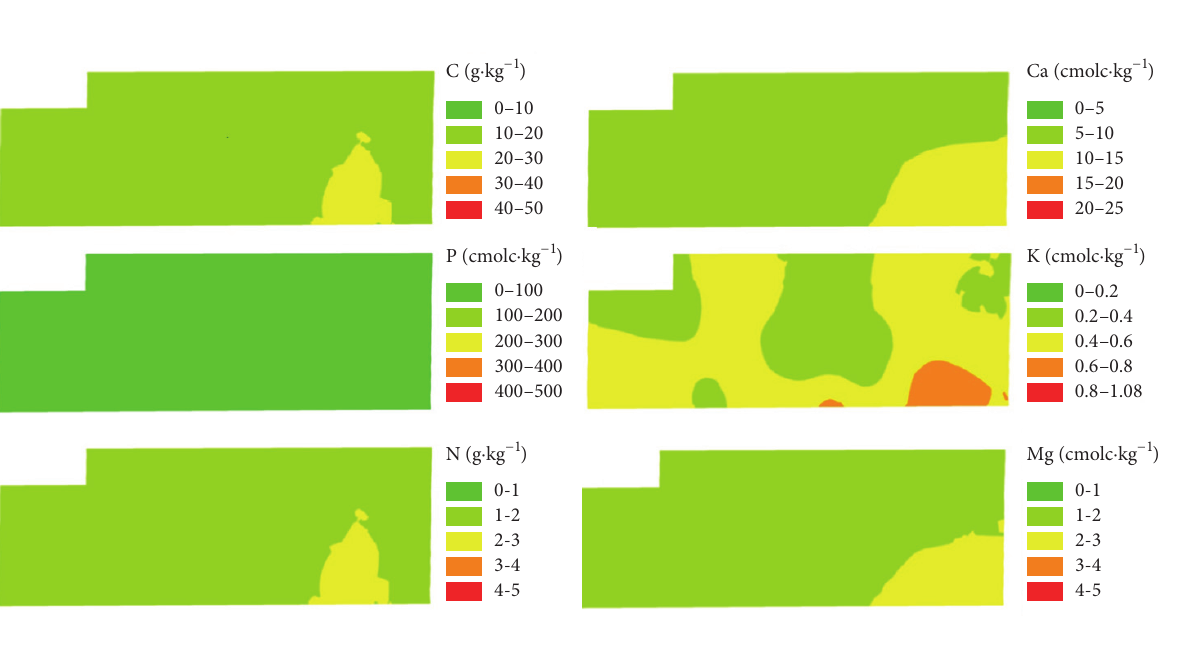
Figure 4: Spatial distribution of nutrients in the soils of vineyard 1 (horizon